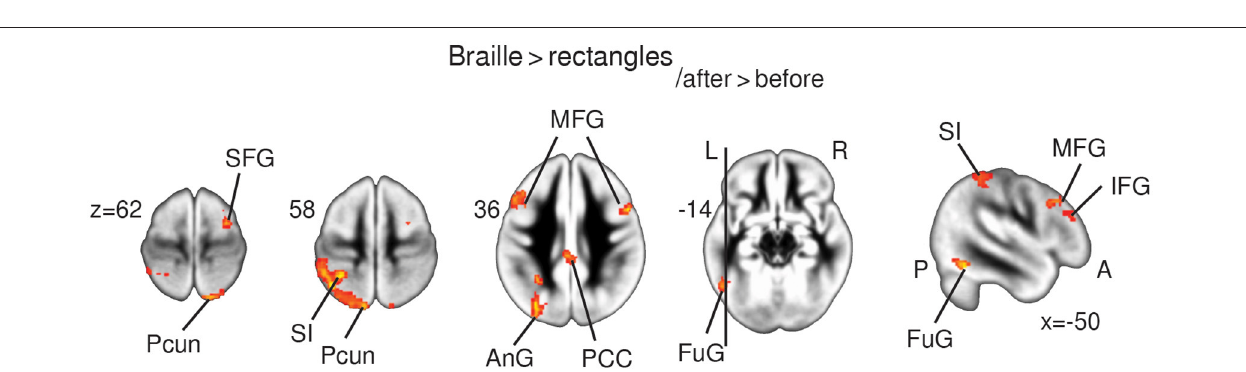
FIGURE 3 | fMRI results. Statistical parametric maps of functional plasticity induced by Braille training. Results from Braille > rectangles after > before comparisons are presented on the axial slices of the gray matter template (MNI). FWE corrected at p < 0.05. Abbreviations: AnG—angular gyrus, FuG—fusiform gyrus, IFG—inferior frontal gyrus, Ins—insula, LinG—lingual gyrus, MFG—medial frontal gyrus, PCC—posterior cingulate cortex, Pcun—precuneus, SFG—superior frontal gyrus, SI—primary somatosensory cortex.